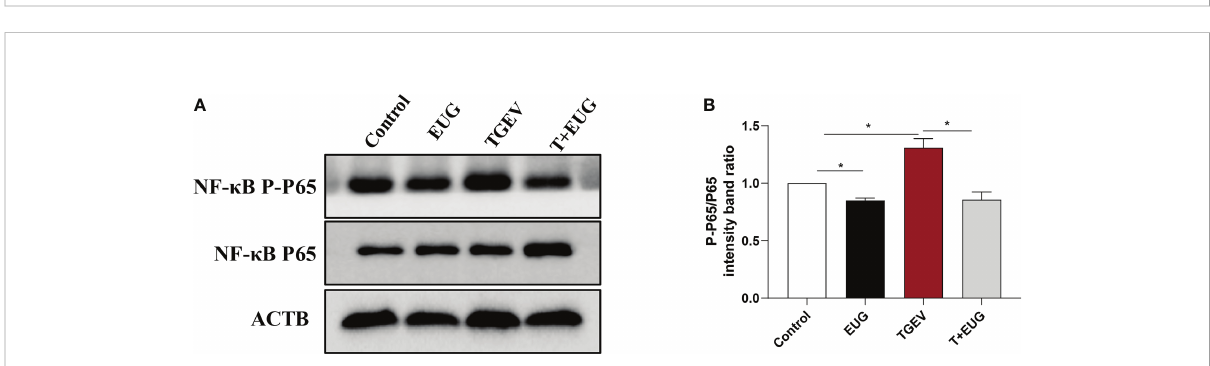
FIGURE 4 Effects of eugenol on jejunum in fl ammatory-related protein expression levels in TGEV-infected weaned piglets. (A, B) Immunoblot analysis and quanti fi cation of NF- k B P-P65 and NF- k B P65 in jejunum mucosa. Data were expressed as mean ± SEM. * p <